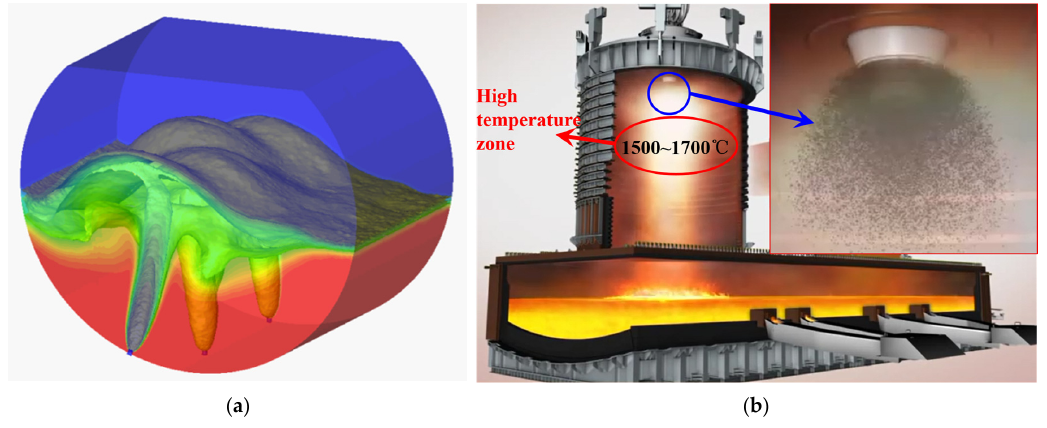
Figure 6. Schematic diagram of multiphase interaction in different processes; ( a ) SKS process; ( b ) Flash process.